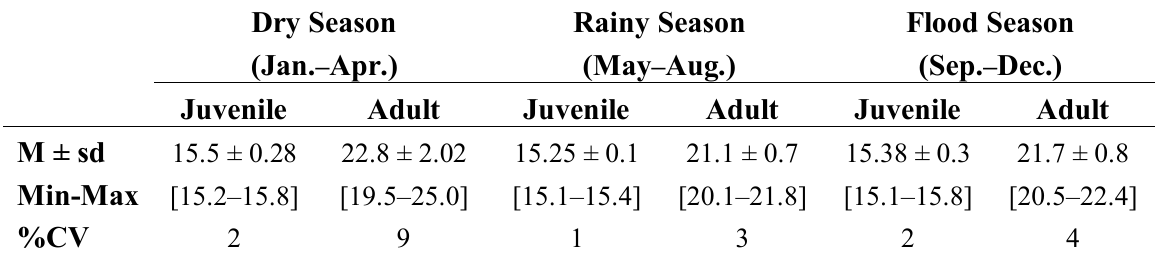
Table 1. Size (cm) of Sarotherodon melanotheron